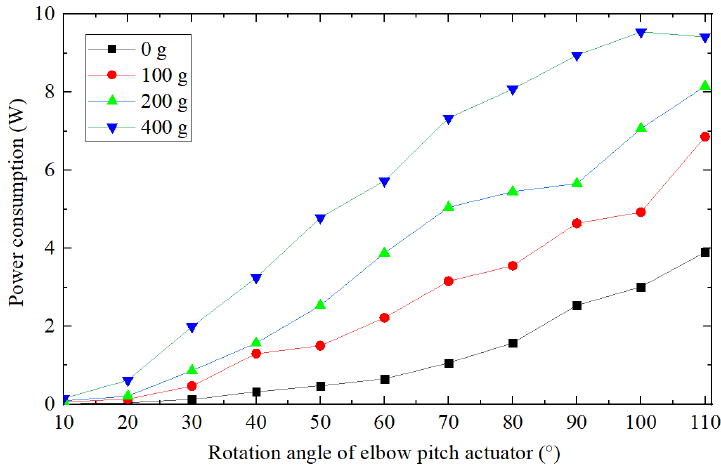
Figure 9. Power consumption of elbow pitch actuator under different external loads.